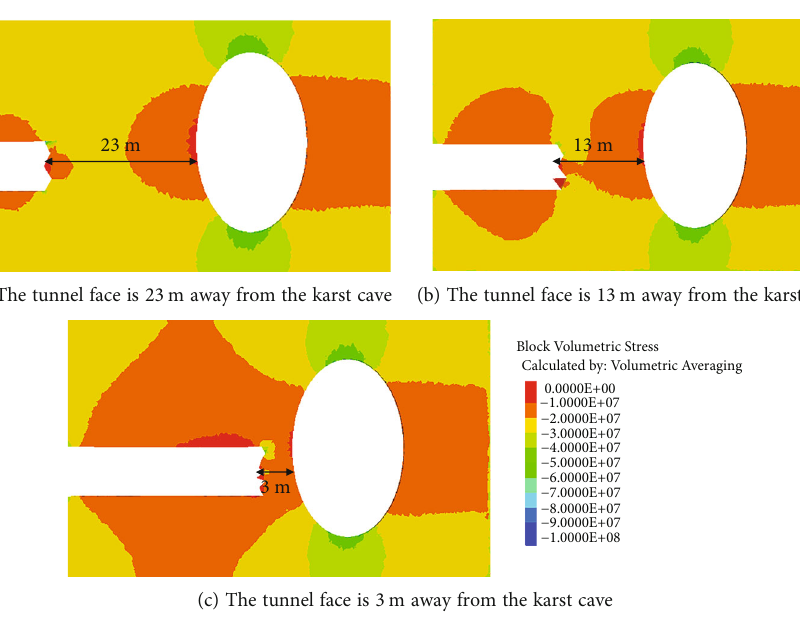
Figure 7: Block volumetric stress of surrounding rock under di ff erent thickness of water-resisting layer.